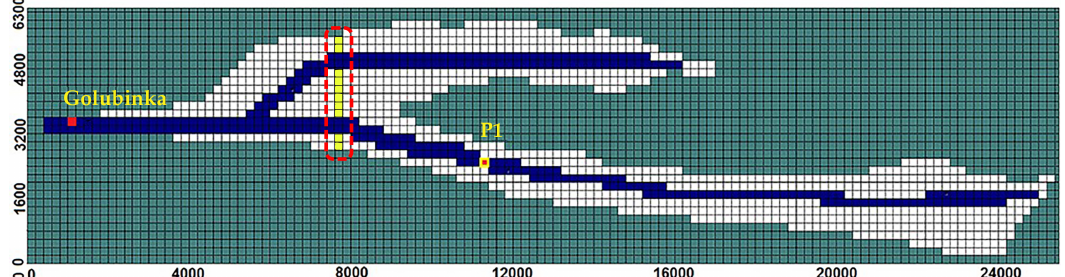
Figure 4. Spatial distribution of hydraulic conductivity coefficients K x , K y , K z in the bottom layer (from − 2 to − 1 m a.s.l.) with the marked section for flow distribution control and boundary conditions (Golubinka and P1). Blue area indicates the values K x , K y , K z = 3.0 · 10 − 1 , and the white area indicates the values K x , K y , K z = 1.0 · 10 − 4 .